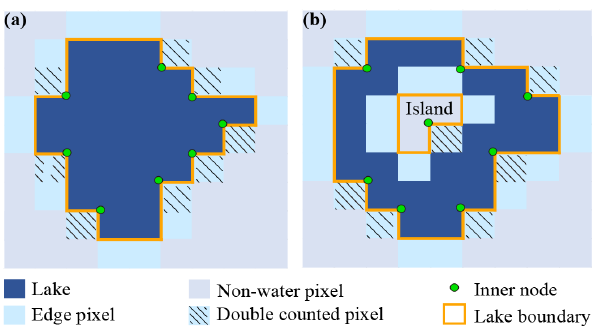
Figure 4. Sketch estimating the actual edge pixels for uncer- tainty calculation of individual glacial lakes (with a and without islands b